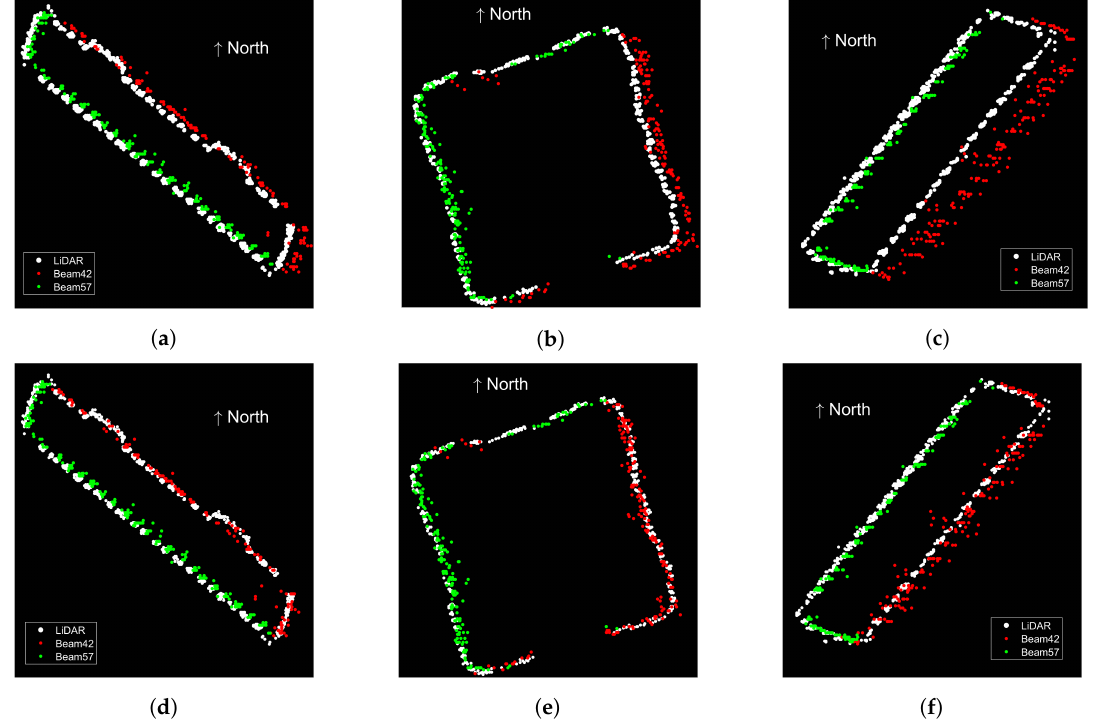
Figure 13. 2D horizontal localization accuracy analysis of PSI point clouds of the test sites marked with cyan arrows in Figure 5 (top: non-corrected, bottom: corrected). The x - and y -axes correspond to the Easting and Northing in UTM. Green and red dots show the ascending and descending point clouds while white dots show the extracted LiDAR footprints. The scale of figures is not identical meaning that the degree of zoom-in is higher in subfigures ( c , f